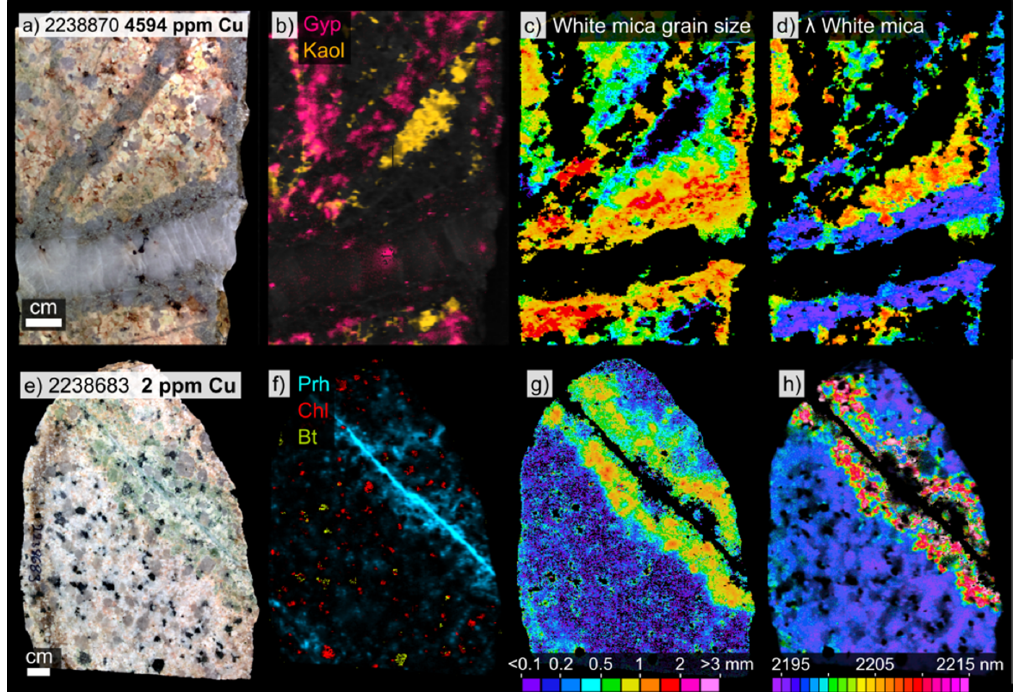
Figure 5. Photographs and processed hyperspectral imagery of samples from the Bethsaida facies. Top: A mineralized sample from within the Valley open pit; ( a ) color photograph; ( b ) distribution of kaolinite (orange) and gypsum (pink); ( c ) spectrally determined white mica grain size (color-scale at bottom), gypsum masked and; ( d ) absorption position of the 2200 nm Al 2 -OH feature exclusively for white mica pixels above 0.5 mm in thickness (color scale at bottom), which masks kaolinite. Gypsum is also independently masked. Bottom: An unmineralized sample located 2 km west of the Valley open pit; ( e ) color photograph; ( f ) distribution of prehnite; ( g ) spectrally determined white mica grain size, and; ( h ) absorption position of the 2200 nm Al2-OH feature for white mica. In the mineralized sample (Figure 5, top), spectrally detected mineralogy is consistent with the reported alteration styles in the Bethsaida facies. The quartz vein selvage consists of coarse-grained white mica, and kaolinite is present in the altered groundmass (Figure 5b). Gypsum is present